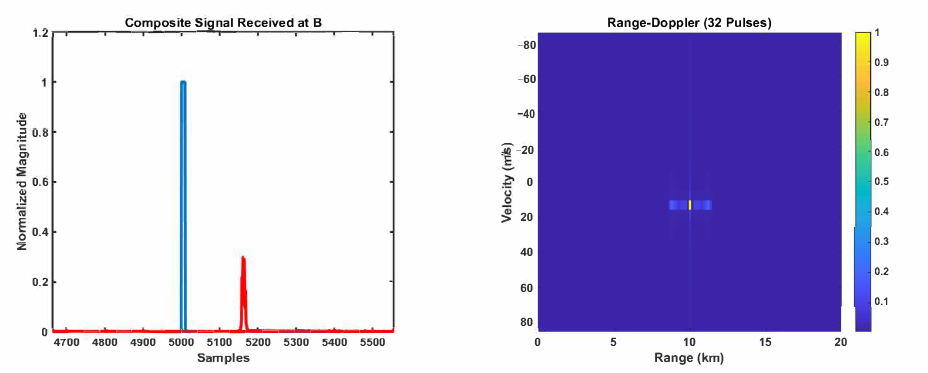
Figure 20. Initial over-the-air results under the first experimental